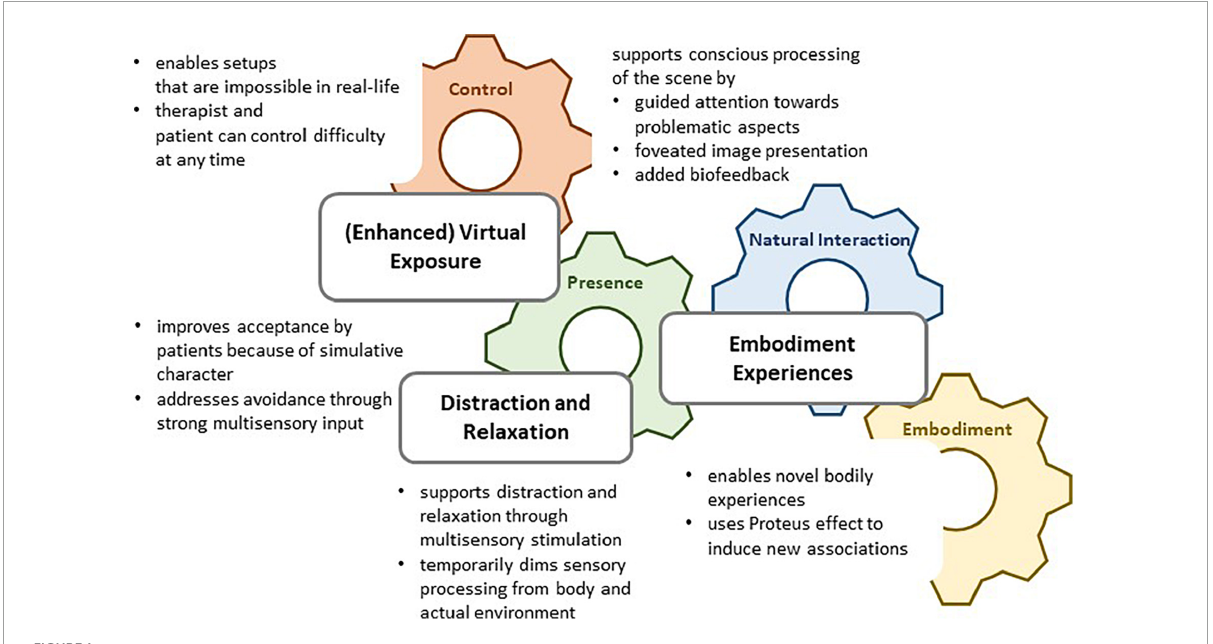
FIGURE1 Virtual reality (VR) as a tool for